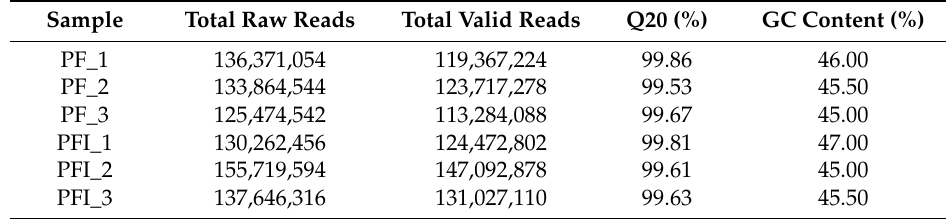
Figure 1. The PCA results of three biological replicates. ( A ) Represents three biological replicates of mRNA, while ( B ) represents miRNA. Table 2. Detailed information on sequencing transcriptome library in healthy P. fortunei (PF) and PaWB-infected P. fortunei (PFI).